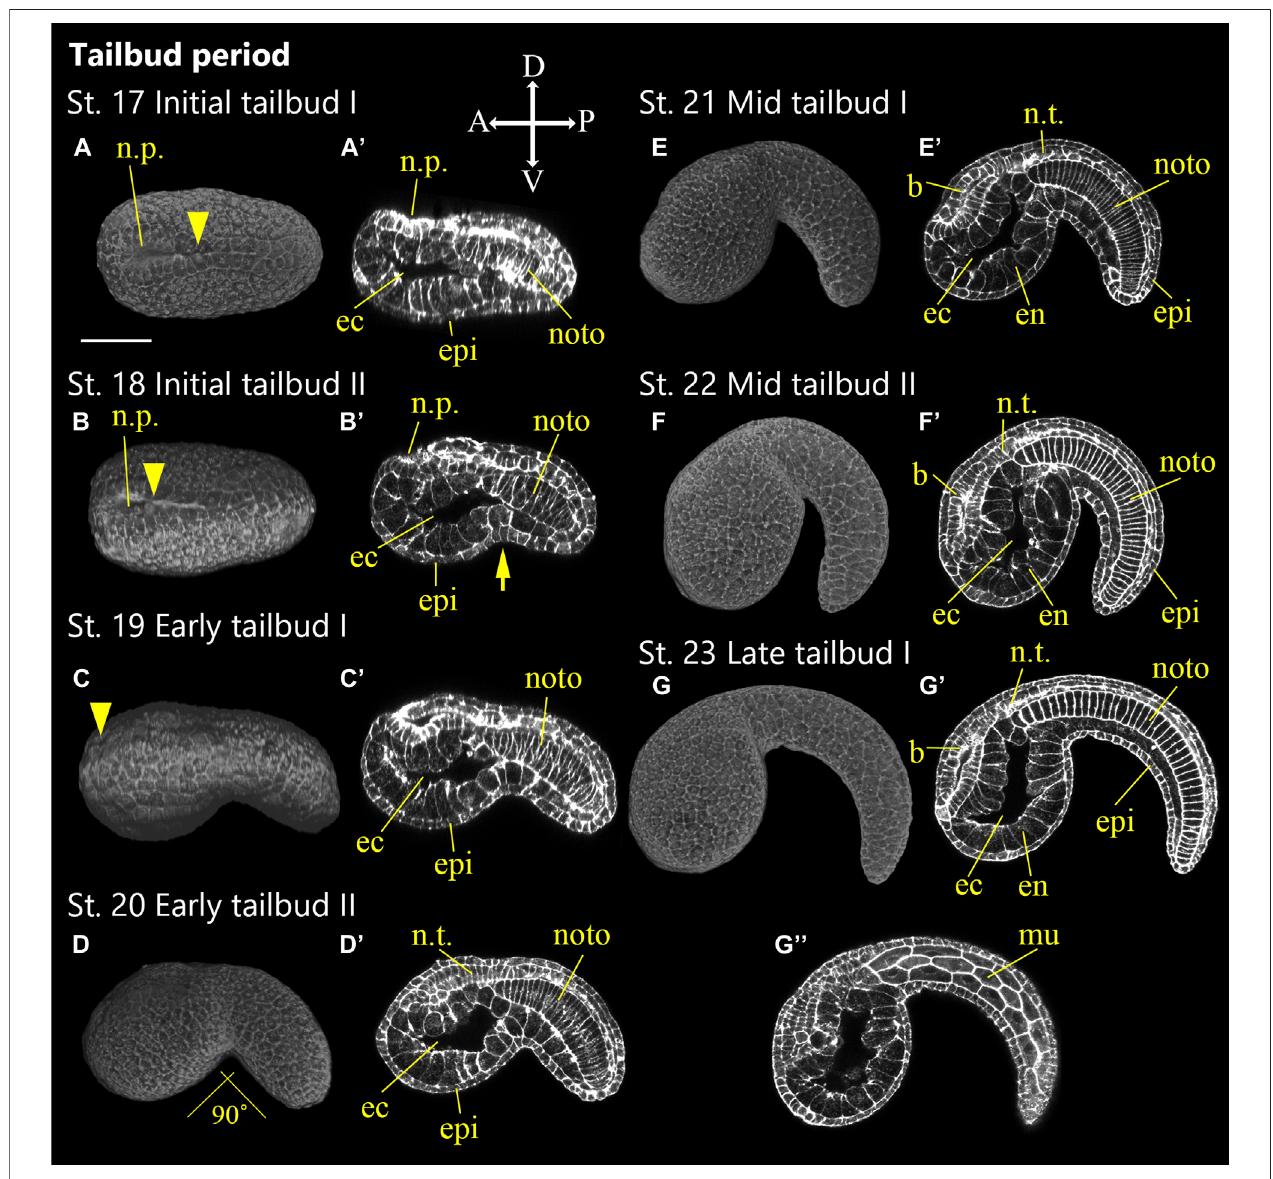
FIGURE 6 | Ascidiella aspersa embryos at the fi rst part of tailbud period. Embryos are stained with Alexa Fluor ™ 546 Phalloidin. Three-dimensional reconstructed images at (A) Stage 17 (initial tailbud I), (B) Stage 18 (initial tailbud II), (C) Stage 19 (early tailbud I), (D) Stage 20 (early tailbud II), (E) Stage 21 (mid tailbud I), (F) Stage 22 (midtailbudII), (G) Stage23(latetailbudI). (A,B) showthedorsalviewsoftheembryos,and (C – G) showthelateralviewsoftheembryos. (A 9 – G 9 ,G 99 ) Longitudinalsection of (A – G) , respectively. (G 99 ) is more lateral section than (G 9 ) . Anterior side of each embryo is left. In (C – G, A 9 – G 9 ,G 99 ) , embryo direction is shown by A, anterior; P, posterior; D, dorsal; V, ventral. The arrow indicates separation between tail and trunk territories. Arrowheads indicates the anterior edge of neural tube closure. b , brain; ec, endodermal cavity; en, endoderm; epi, epidermis; mech, mesenchyme; mu, muscle; noto, notochord; n.p., neuropore; n.t., neural tube. Scale bar: 50 μ m.